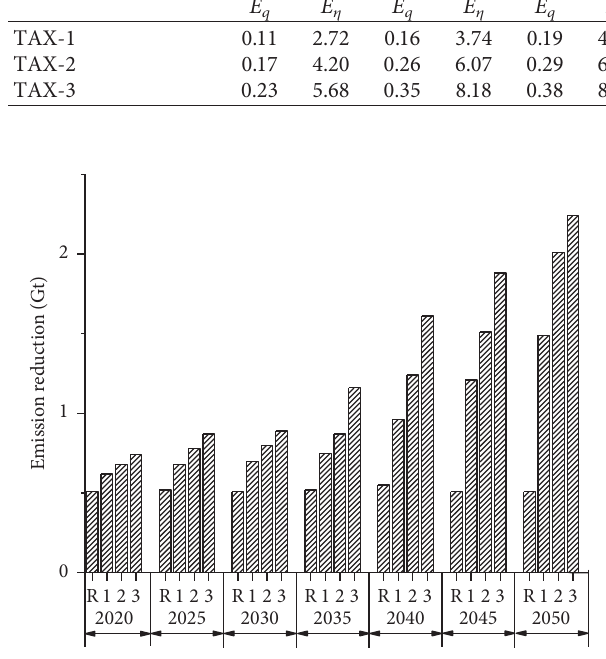
Figure 6: CO 2 emission reduction characteristics of power industry.